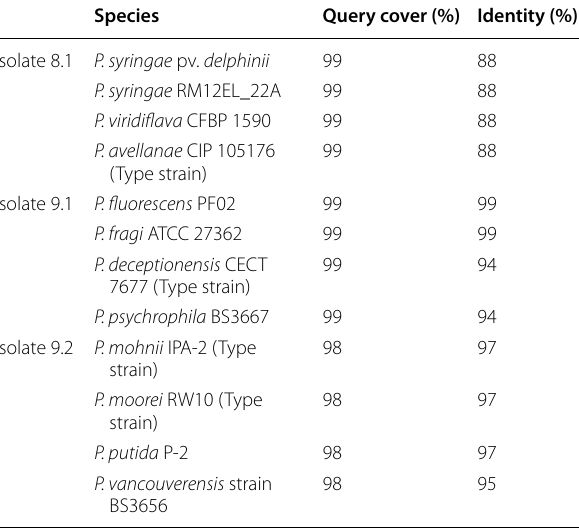
Table 2 Identification of isolates from the genus Pseu- domonas by partial gyrB sequencing